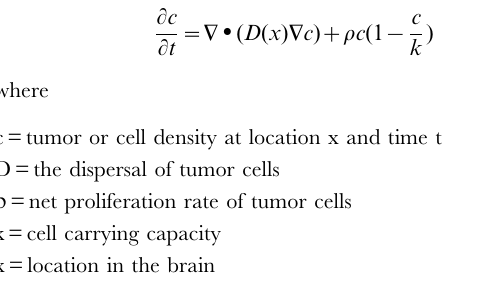
r /D: Figure 1a,c,e. low r /D: Figure 1b,d,f). The most diffuse tumors (low r /D) are those with a low proliferative potential ( r ) relative to their invasive potential (D); the least diffuse, most nodular, tumors (high r /D) are those with a high proliferative potential relative to their invasive potential. We estimated tumor volumes from T1Gd and T2/FLAIR MRIs using a semi-